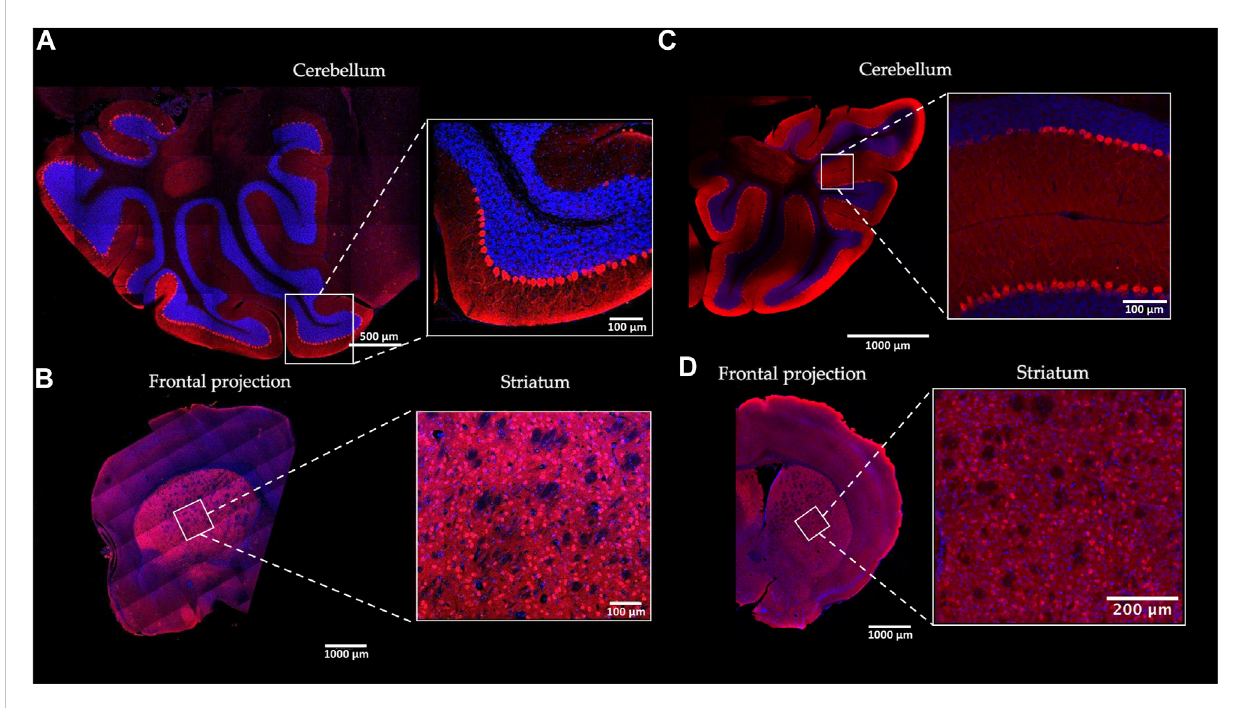
FIGURE 4 G α o protein localization in the mouse brain. The distribution pattern of G α o in the brain of homozygous Gnao1-GGA mice (A, B) was compared to the wild-type CBA control mice (C, D) . Sagittal (cerebellum) (A) and Coronal (striatum) (B) cryosections of the Gnao1-GGA brains were examined by immuno fl uorescence with G α o-speci fi c antibody (red). The nuclei were stained with DAPI (blue). Similarly, sagittal (C) and coronal (D) brain cryosections of the CBA mice were prepared and analyzed. Scale bars are shown for each